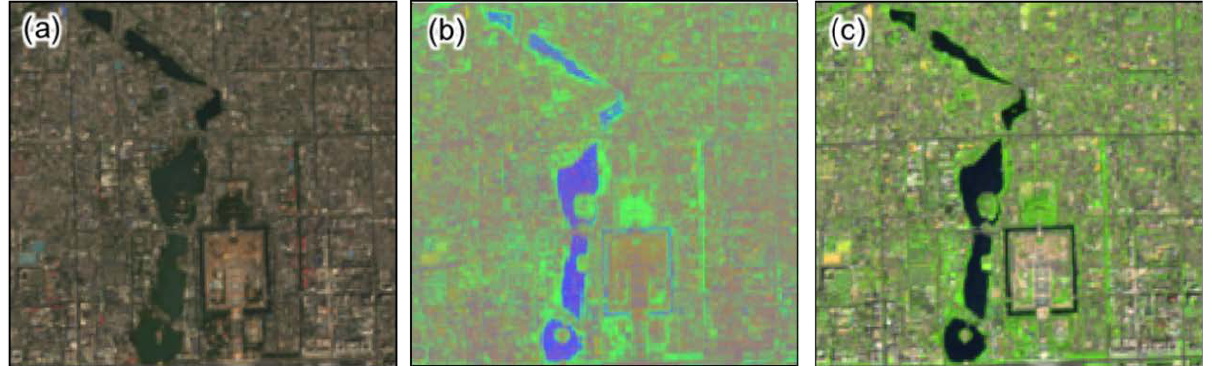
Figure 11. A scene in Beijing under different color composite images: ( a ) red–green–blue, ( b ) NDBI–NDVI–mNDWI, and ( c ) SWIR1–NIR–red.